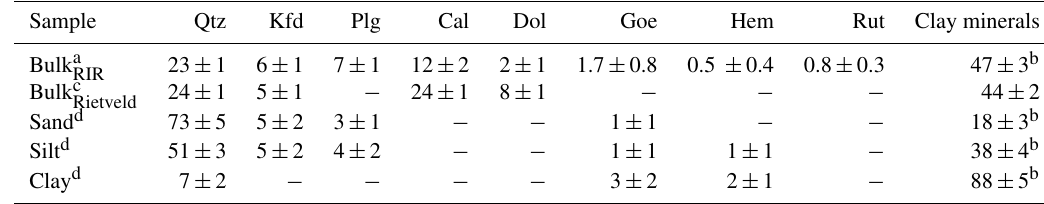
Table 1. Semiquantitative XRD analysis of Saharan dust powder samples (wt%; ± 1 σ) .